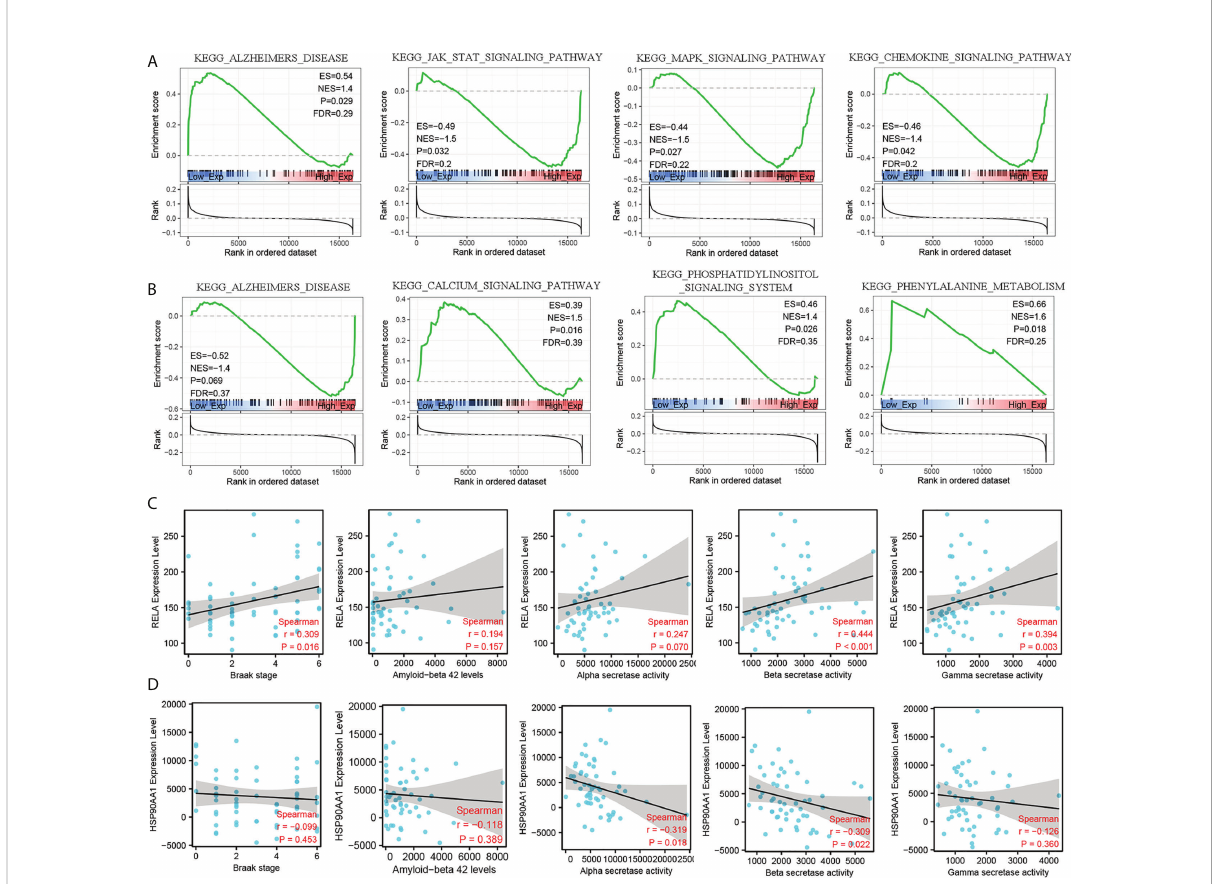
FIGURE 6 GSEA analysis of hub IRDEGs and their correlation with AD-related pathological features. (A) GSEA analysis of RELA. (B) GSEA analysis of HSP90AA1. (C) Spearman ’ s correlation analysis between the RELA expression level and Braak stage, a -, b -, and g -secretase activity, and A b 42 levels. (D) Spearman ’ s correlation analysis between the HSP90AA1 expression level and Braak stage, a -, b -, and g -secretase activity, and A b 42 levels. ES, enrichment score; NES, normalized enrichment score; FDR, false discovery rate; GSEA, gene set enrichment